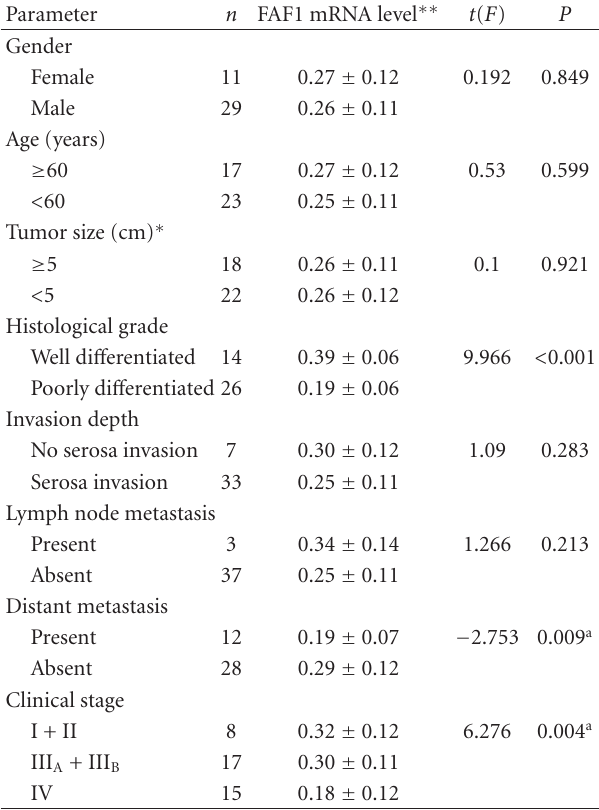
Table 1: FAF1 mRNA expression and clinicopathological charac- teristics of gastric